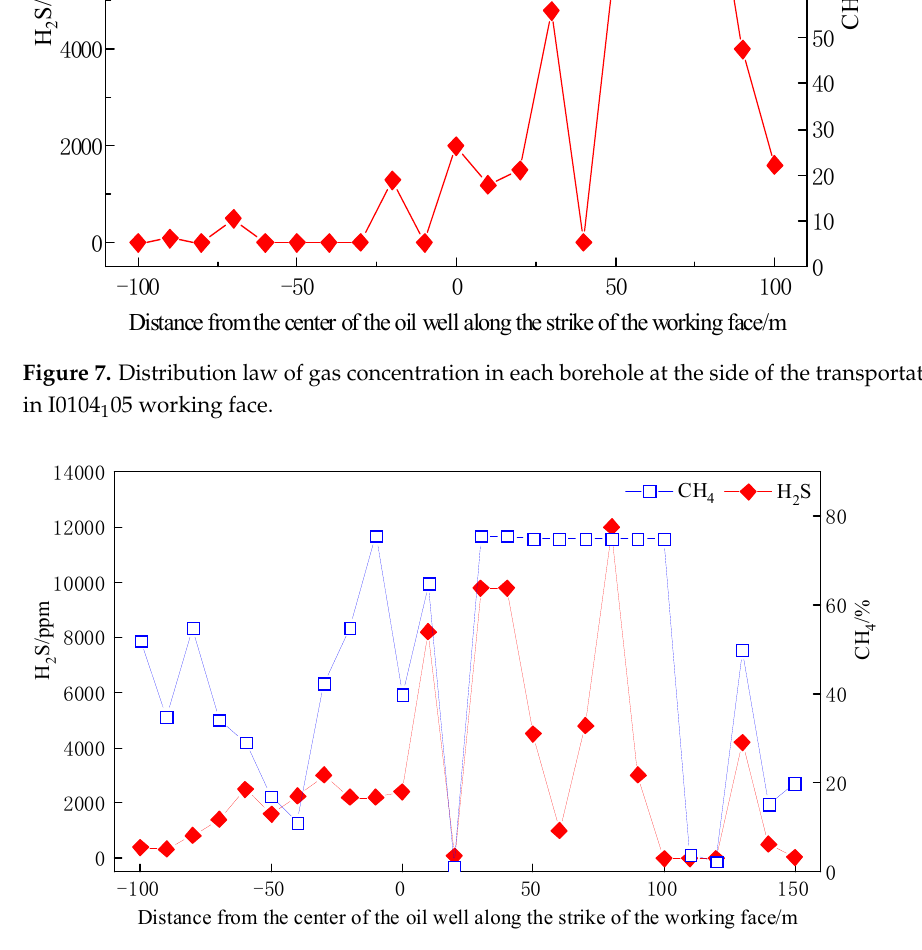
Figure 8. Gas concentration distribution law in each borehole on the side of return airway in I0104 1 05 working